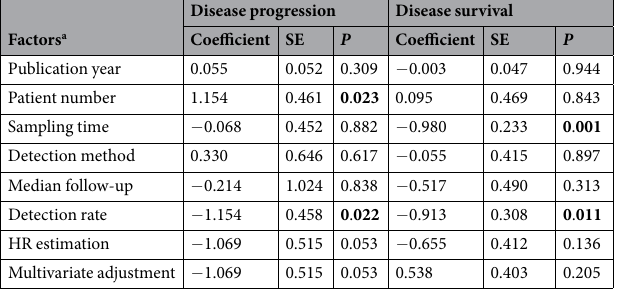
Table 2. Univariate meta-regression analyses for exploring potential sources of heterogeneity. Abbreviations: SE, standard error of the coefficient. a Patient number referred to < 100 versus ≥ 100. Sampling time referred to preoperative versus postoperative. Detection method referred to RT-PCR versus immunological methods. Median follow-up referred to < 40 months versus ≥ 40 months. Detection rate referred to < 35% versus ≥ 35% (35% was the median of the detection rate of each study included in overall analysis). HR estimation referred to reported in articles versus extrapolated by data. Multivariate adjustment referred to yes versus